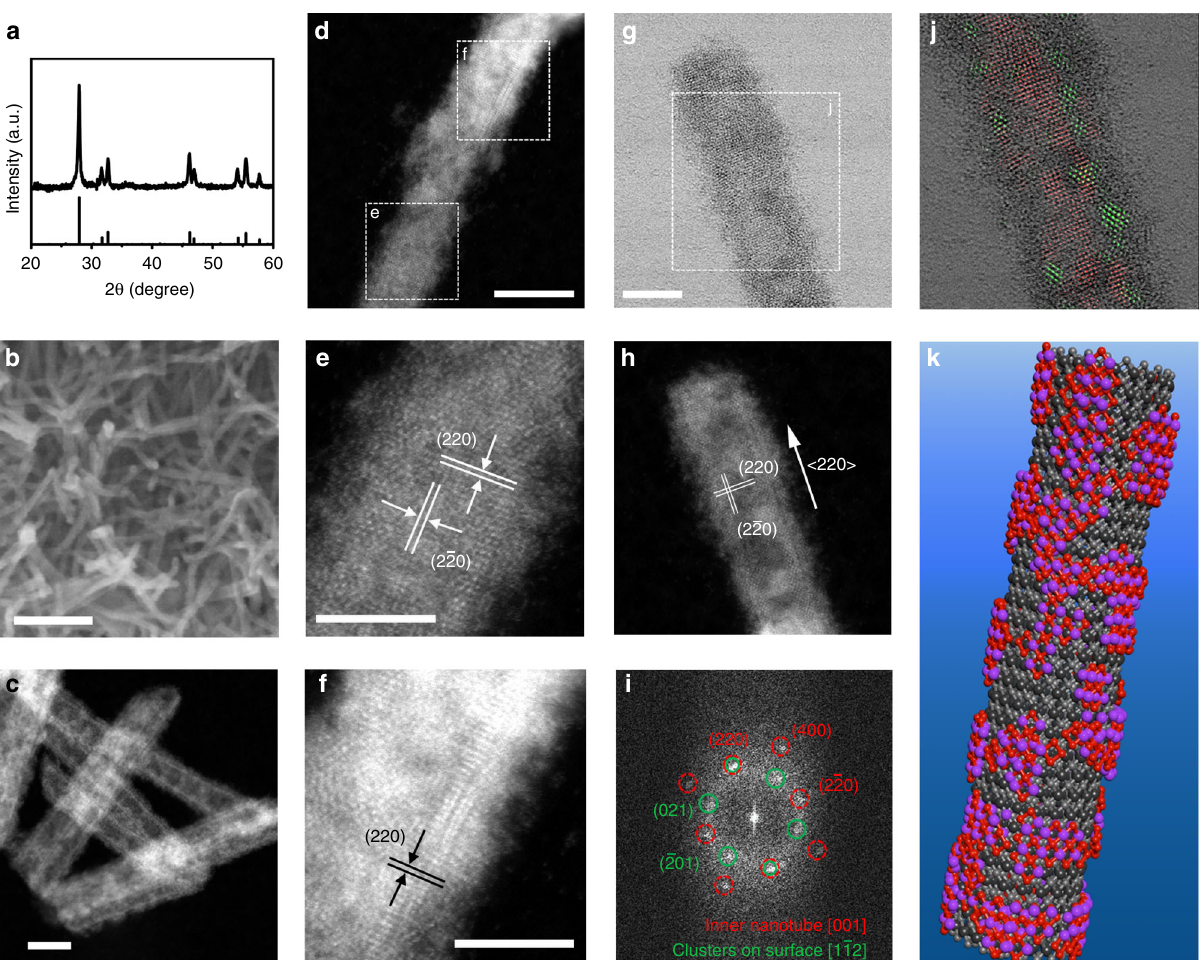
Fig. 1 Structural characterizations of bismuth oxide nanotubes. a XRD pattern, b SEM image, and c , d STEM-HAADF images of Bi 2 O 3 NTs. e , f High- resolution images of the enclosed areas in ( d ). g – i Simultaneously acquired g STEM-BF image, h STEM-HAADF image, and i corresponding FFT pattern of a Bi 2 O 3 nanotube (NT). j Overlay of the FFT fi ltered fringes with the original STEM-BF image in ( g ); the fringes in red are constructed by fi ltering the FFT spots highlighted in red in ( i ), and the green fringes are constructed from the green spots. k Schematic illustration of the structure of Bi 2 O 3 NTs; the black spheres represent the crystalline inner walls, and the red and purple spheres represent the fragmented outer walls. Scale bar, 100 nm ( b ); 10 nm ( c , d ); 5 nm ( e – g